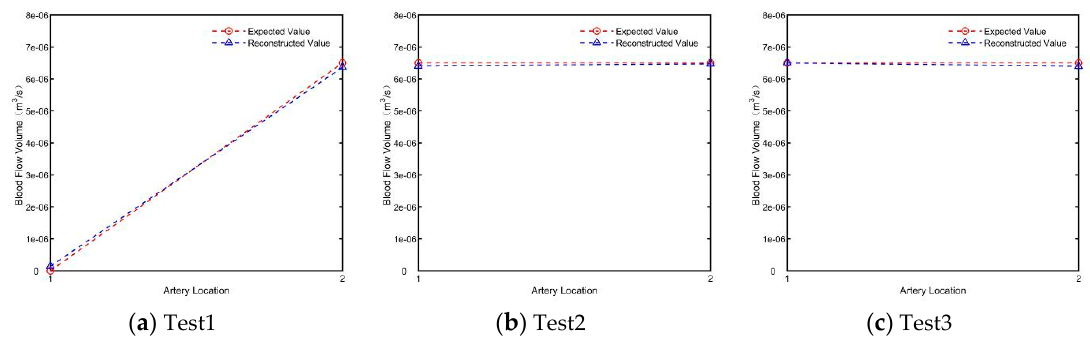
Figure 9. The difference of potential in different test conditions.